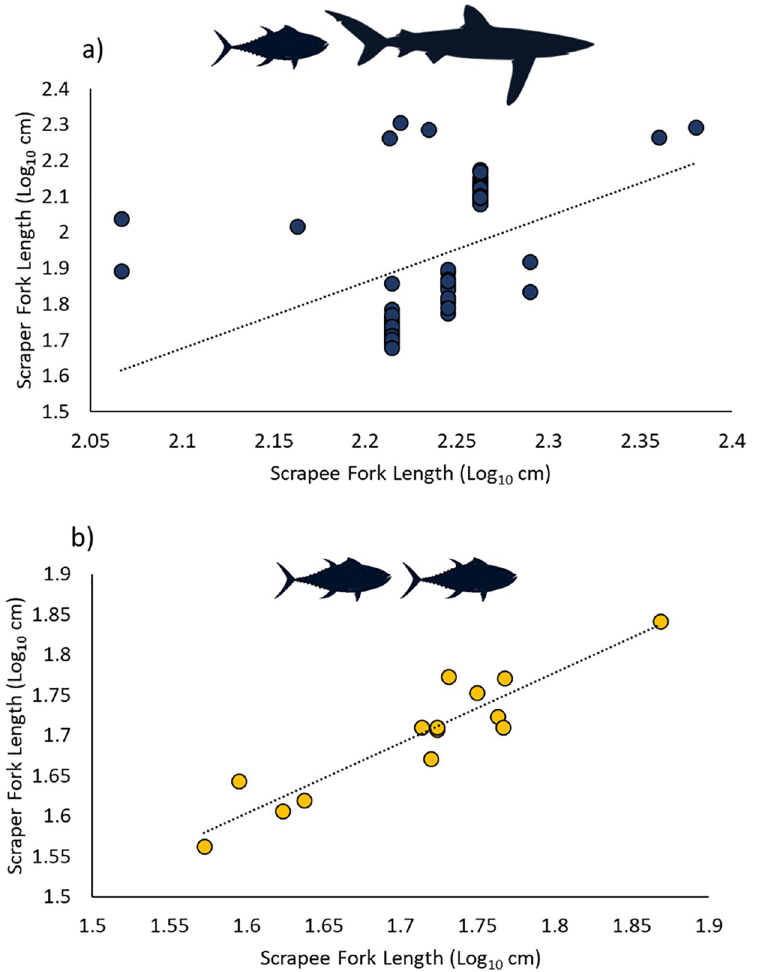
Fig 3. Relationship of scraper to scrapee fork length (log 10 (x) transformed) for a) teleost-shark (log 10 (Scraper FL) = 1.85 x log 10 (Scrapee FL)– 2.20; R 2 = 0.185) and b) teleost-teleost conspecific (log 10 (Scraper FL) = 0.872 x log 10 (Scrapee FL)– 0.208; R 2 = 0.861) pairs for independent observations of scraping interactions across all sample